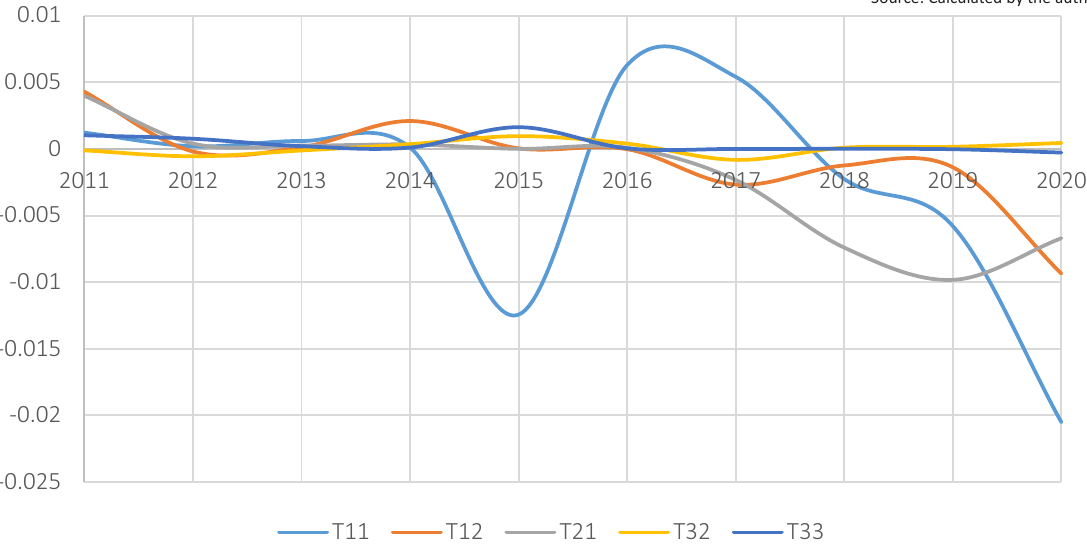
Figure 2. Dynamics of average annual entropy by types of taxes